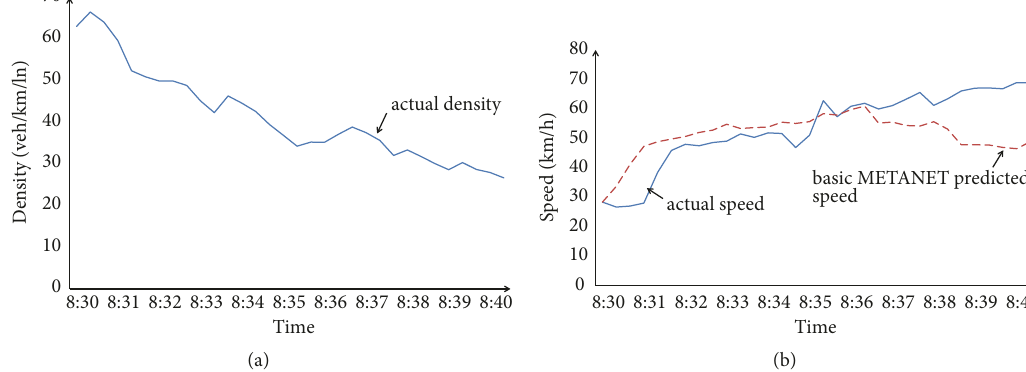
Figure 1: Variation of density corresponding actual and basic METANET predicted speeds: (a) actual density and (b) actual speed and basic METANET